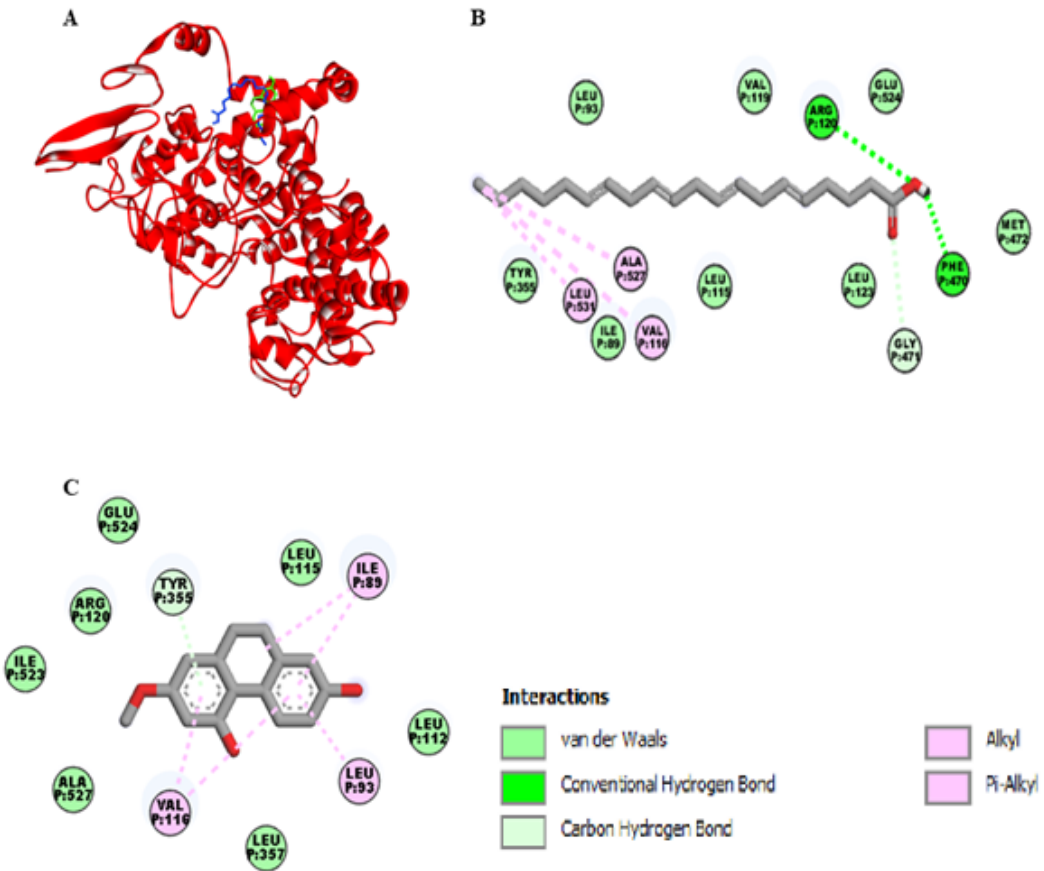
Figure 3. Docking lusianthridin into the COX-1 enzyme. ( A ) 3D interaction of arachidonic acid (blue) and lusianthridin (green) with the COX-1 enzyme. 2D interaction of binding mode for ( B ) arachidonic acid ( C ) lusianthridin inside the COX-1 enzyme.